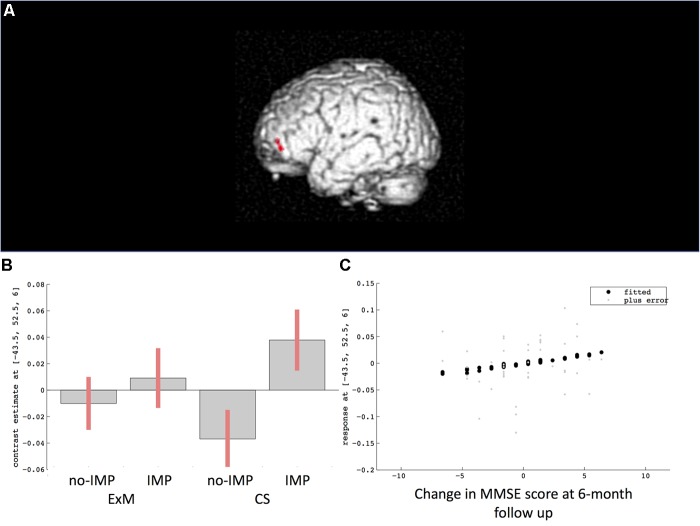
Results of subtraction analysis between the IMP and non-IMP subgroups of the whole cohort (A,B). Correlation between changes in MMSE scores and gray matter (GM) volume (C). IMP, improvement; no-IMP, no-improvement; MMSE, Mini Mental State Examination.